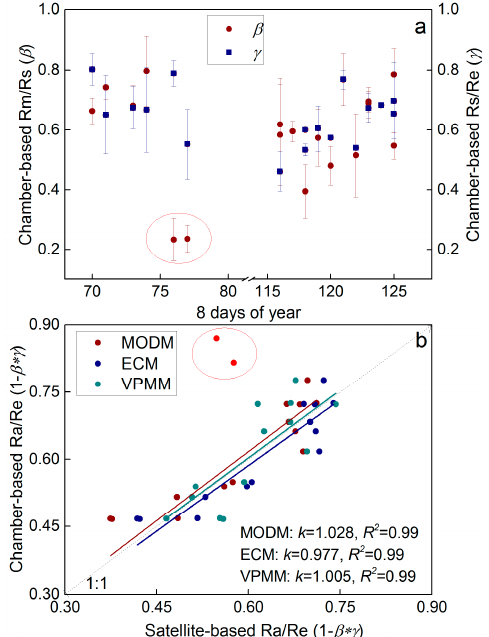
Figure 7. Chamber-based estimations for the ratios of ecosystem respiration (Re) components from 2010 to 2011 ( a ); and comparison with the corresponding ratios based on the satellite-based Re partitions ( b ). Rm, Rs and Ra are heterotrophic respiration, autotrophic respiration and soil respiration, respectively. Error bars in ( a ) are standard deviations of the mean values from sample plots ( n = 4 for β and 7 for γ ). Dots in red circles in ( a , b ) are the abnormal measurements due to the high moisture condition. k values and dashed line in ( b ) are the linear slope between modeled Ra/Re and chamber-based Ra/Re, and the reference line of 1:1, respectively. All linear regressions are extremely significant ( p < 0.0001). Different Re estimations based on the diverse GPP estimation models are identical to the Figure 1.